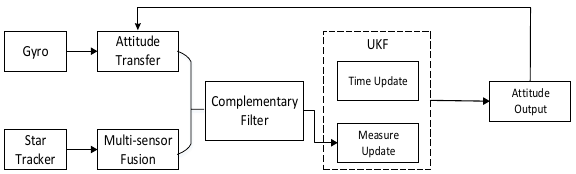
Figure 2. Flow chart of attitude estimation based on CF&UKF The mean and variance of the nonlinear system is estimated by means of unscented transformation in UKF (Crassidis et al., 2003). In the filtering process, 2n+1 sampling points